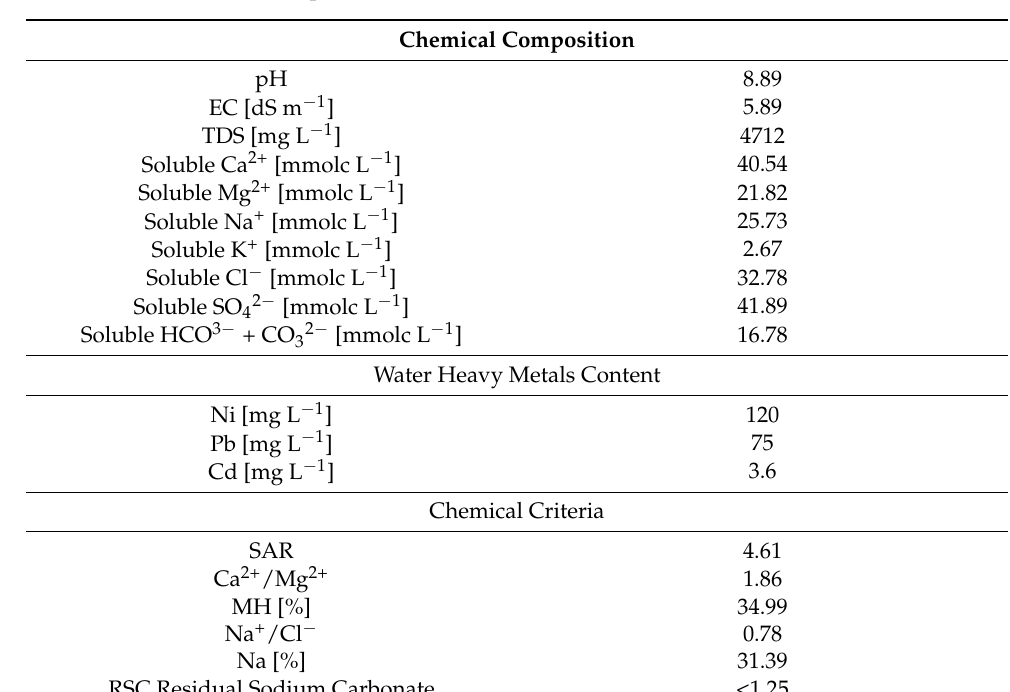
Figure 3. Location map showing Al-Moheet drain and study area. Table 3. Water chemical composition of al-Moheet drain water .